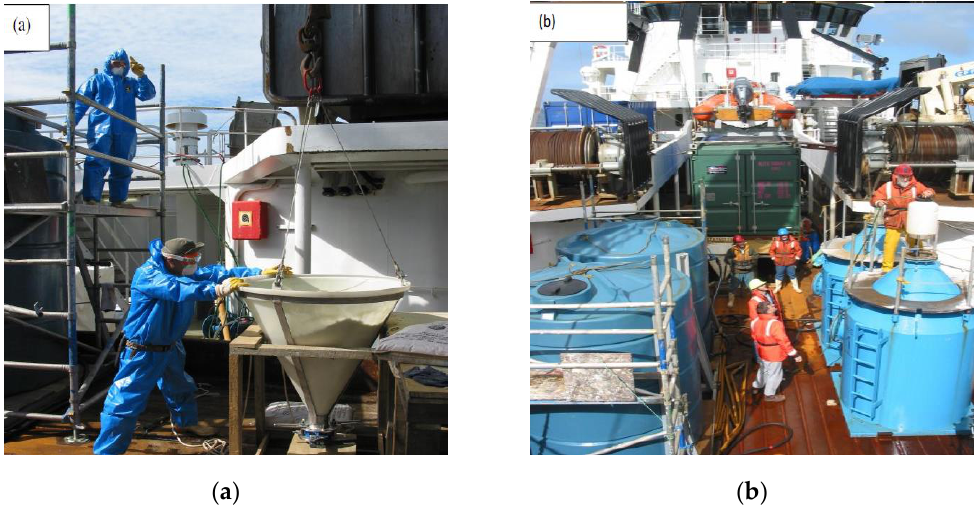
Figure 2. Preparing ( a ) the Fe and ( b ) SF 6 solutions for transfer to the holding tanks. Table 1. Information on iron infusions during the SAGE experiment